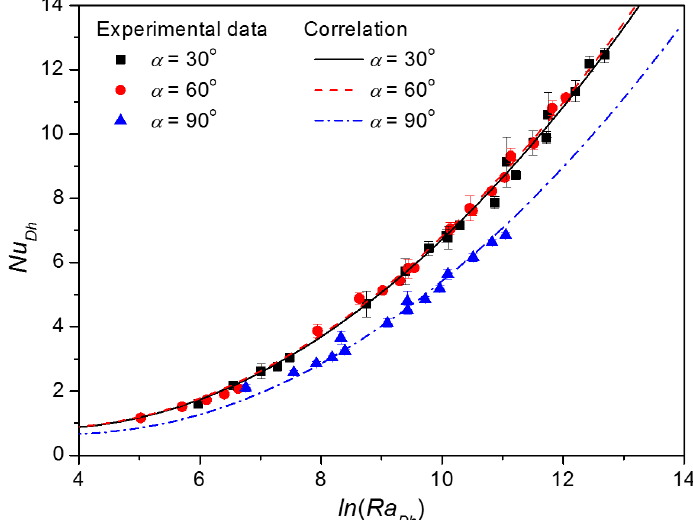
Figure 6. Nusselt numbers calculated using proposed correlation and those from experimental data.